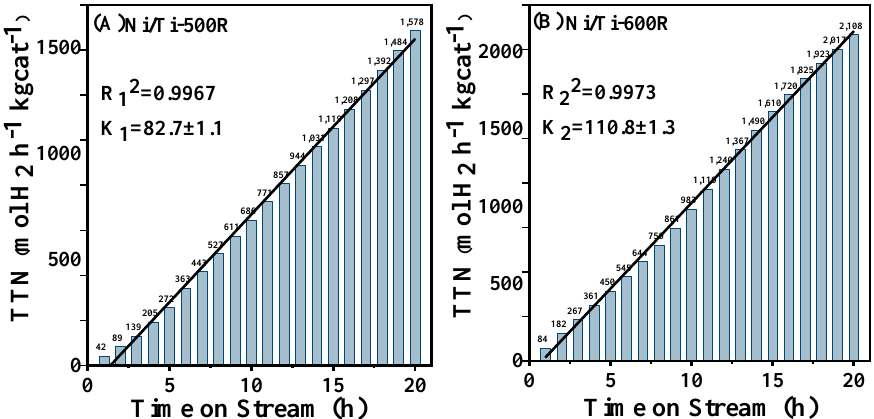
Figure 7. Stability test of ( A ) Ni/Ti-500R and ( B ) Ni/Ti-600R catalysts for hydrogen production in 20 h.